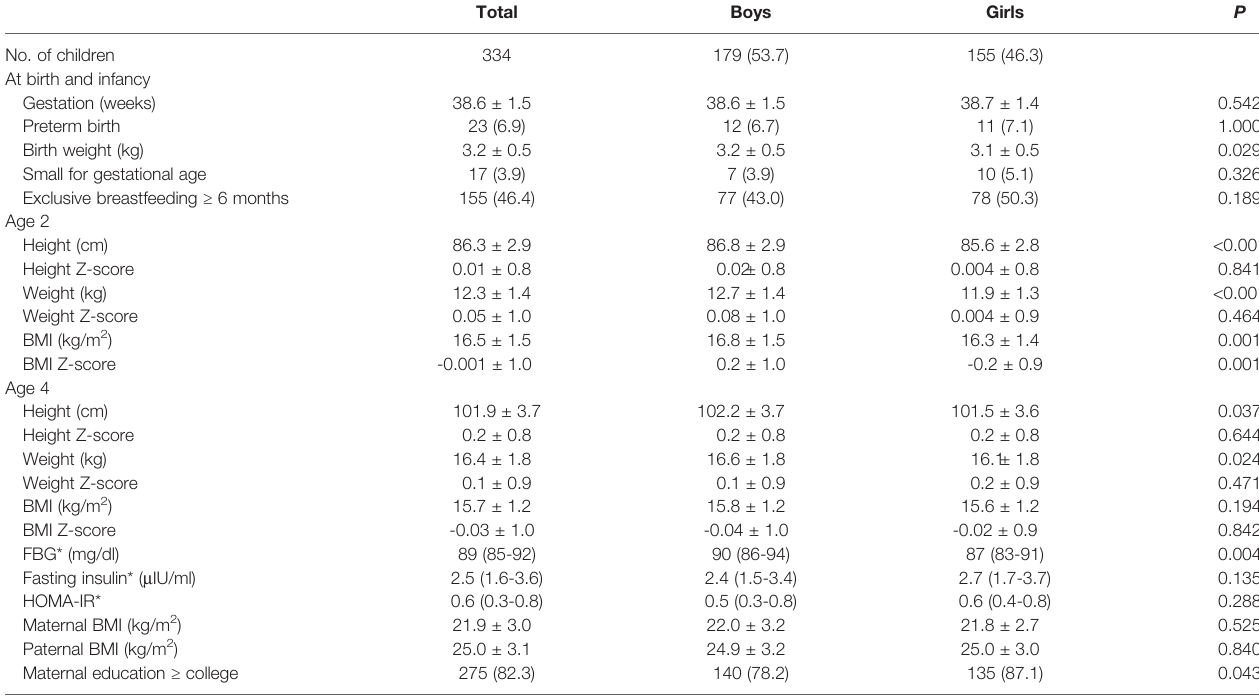
TABLE 1 | Clinical characteristics of the participants.